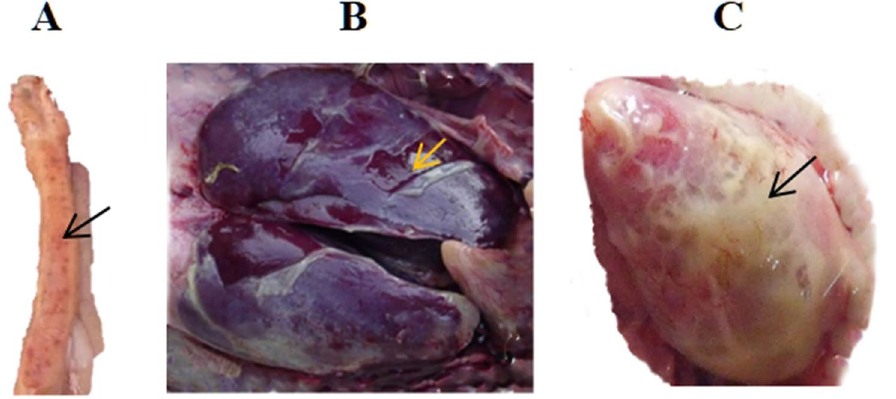
Figure 1. Colibacillosis chicks show severe intestinal bleeding site ( A ), perihepatitis ( B ) and pericarditis ( C